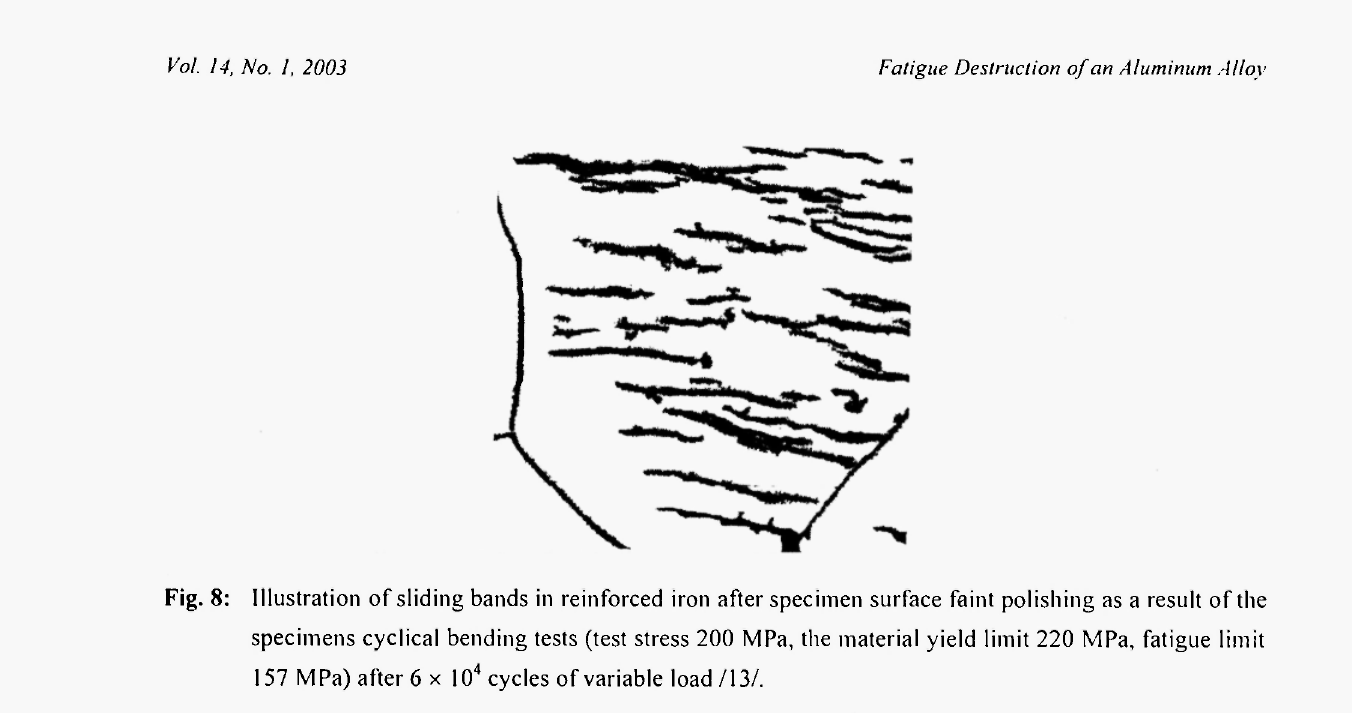
Fig. 8: Illustration of sliding bands in reinforced iron after specimen surface faint polishing as a result of the specimens cyclical bending tests (test stress 200 MPa, the material yield limit 220 MPa, fatigue limit 157 MPa) after 6 χ 10 4 cycles of variable load